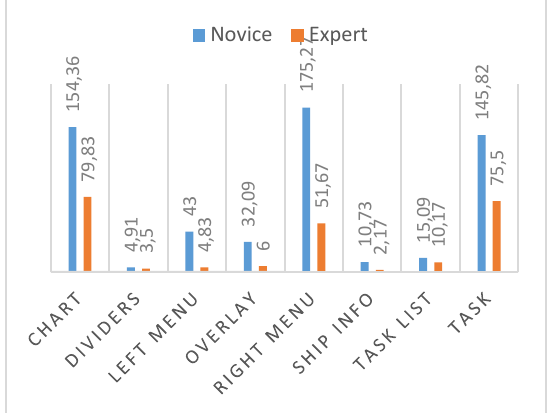
Figure 5. Comparison of means of total fixation counts of nov- ice and expert participants on use of ecdis.